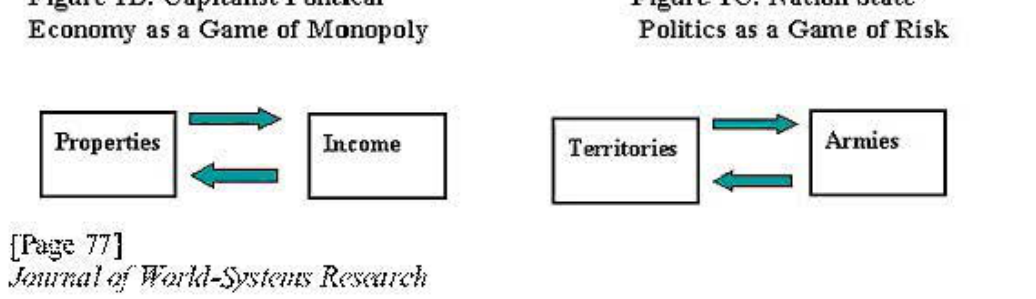
Figure lB: Capitalist Political Figure 1 C: N atio11 State